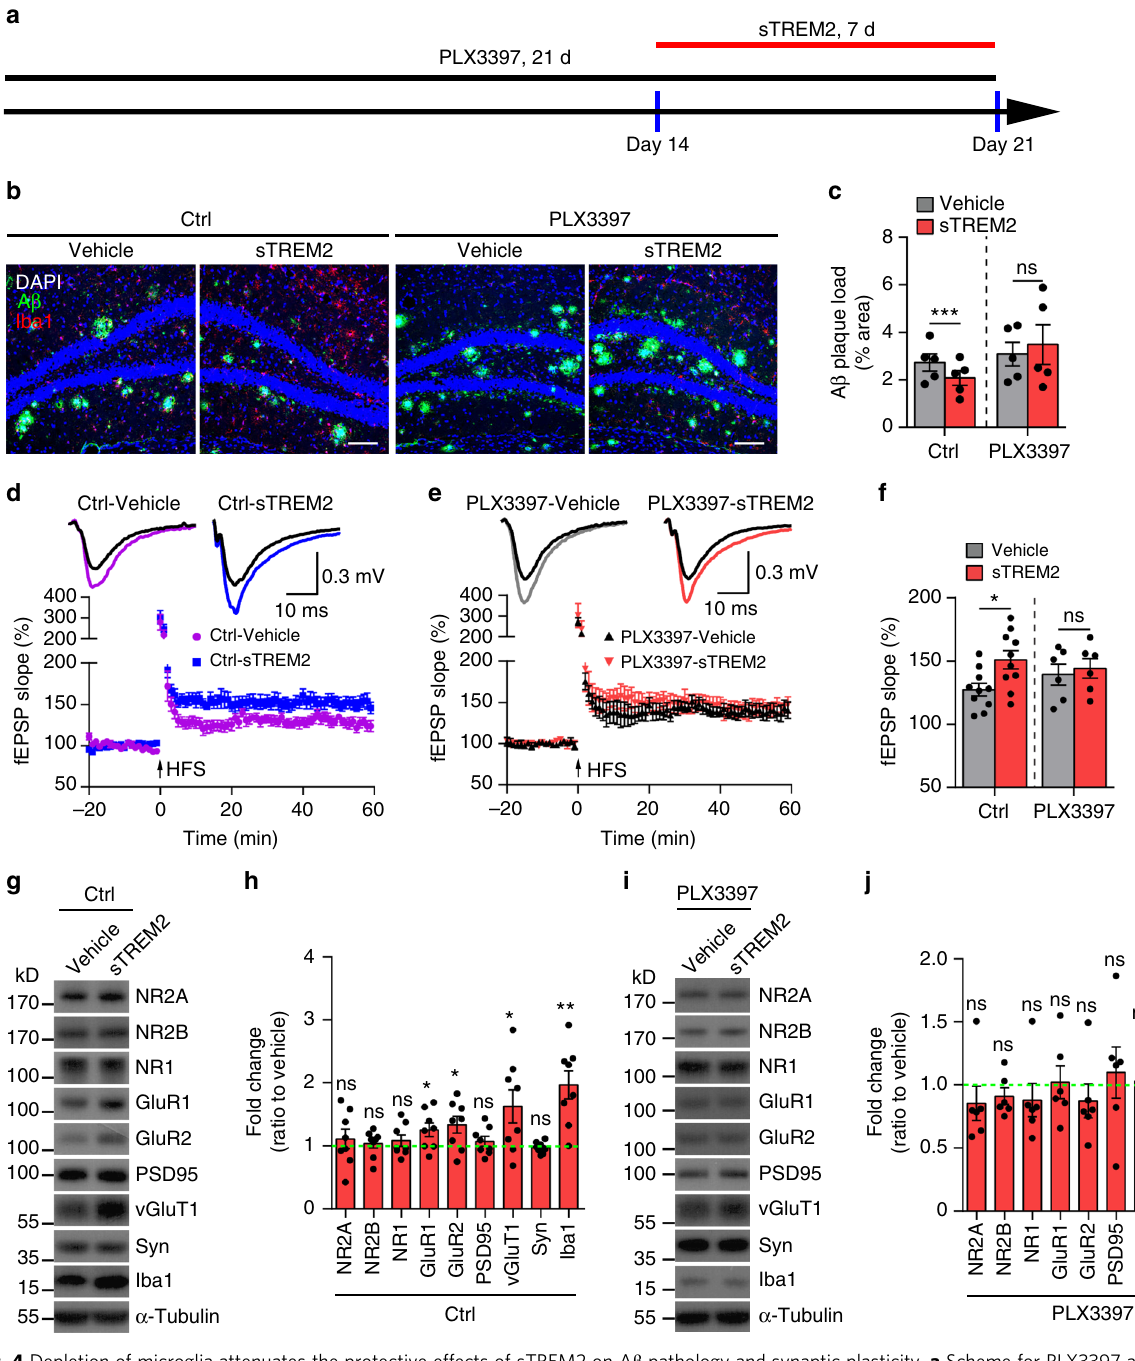
Fig. 4 Depletion of microglia attenuates the protective effects of sTREM2 on A β pathology and synaptic plasticity. a Scheme for PLX3397 administration and sTREM2 injection in 5×FAD mice. b The 5×FAD mice were fed with either PLX3397 or control chow for 14 days and then injected with either sTREM2 protein or vehicle control. After continued feeding with PLX3397 or control chow for 7 days, coronal sections were stained with DAPI (blue) for nuclei, MOAB-2 (green) for A β , and Iba1 (red) for microglia. Representative images of the hippocampus region are shown. Original magni fi cation ×20; scale bar, 100 μ m. c Quantitation of amyloid plaque deposition in b ( n = 5 mice, 18 fi elds of ctrl and 22 fi elds of PLX3397 for analysis, paired Student ’ s t test). d , e Brain slices from control chow ( d ) or PLX3397-fed ( e ) 5×FAD mice were incubated with 50 nM recombinant sTREM2 protein for 1 h at room temperature, and transferred to the chamber for LTP recording. Time course of fEPSP measures were recorded in the hippocampal CA1 region before and after 100-Hz stimulation in the Schaffer collateral region. Normalized fEPSP slopes were plotted every 1 min for each group. f The averaged fEPSPs recorded 50 – 60 min after induction of LTP ( n = 10 slices for Ctrl, n = 6 slices for PLX3397, four mice per group, unpaired Student ’ s t test). g Synaptic proteins from the hippocampi were analyzed by Western blotting 7 days after vehicle or sTREM2 protein injection to the 5×FAD mice fed with control chow. h Quantitation of Western blots in g ( n = 8 mice per group, paired Student ’ s t test). i Synaptic proteins from the hippocampi were analyzed by Western blotting 7 days after vehicle or sTREM2 protein injection to the 5×FAD mice fed with PLX3397. j Quantitation of Western blots in i ( n = 6 mice per group, paired Student ’ s t test). All data are presented as mean ± SEM. * p < 0.05; ** p < 0.01; *** p < 0.001; ns, not signi fi